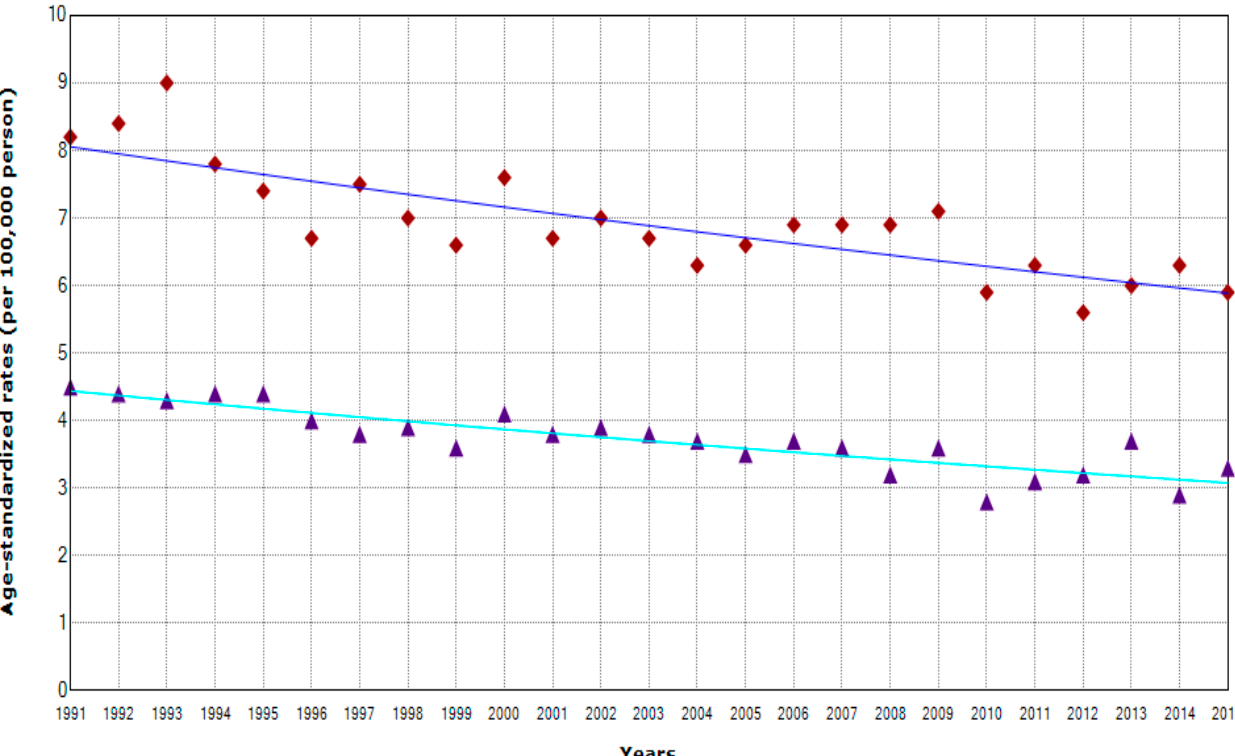
Figure 2. Joinpoint regression analysis of liver cancer mortality in Serbia, by gender, 1991–2015: Men: 0 Joinpoints vs. Women: 0 Joinpoints. Legend: ^ Statistically significant trend; APC, Average Percentage Change.